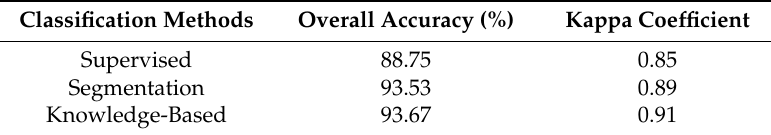
Table 4. Image classification accuracy